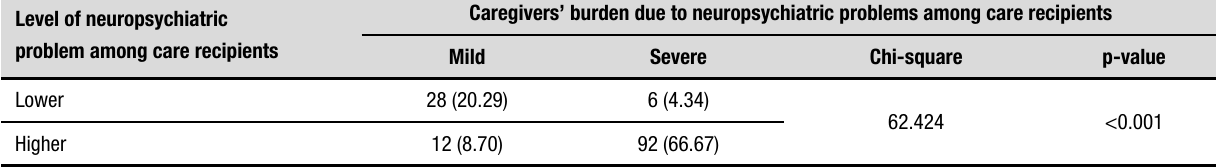
Table 4. Association between care-recipients’ overall neuropsychiatric problem and caregivers’ burden.